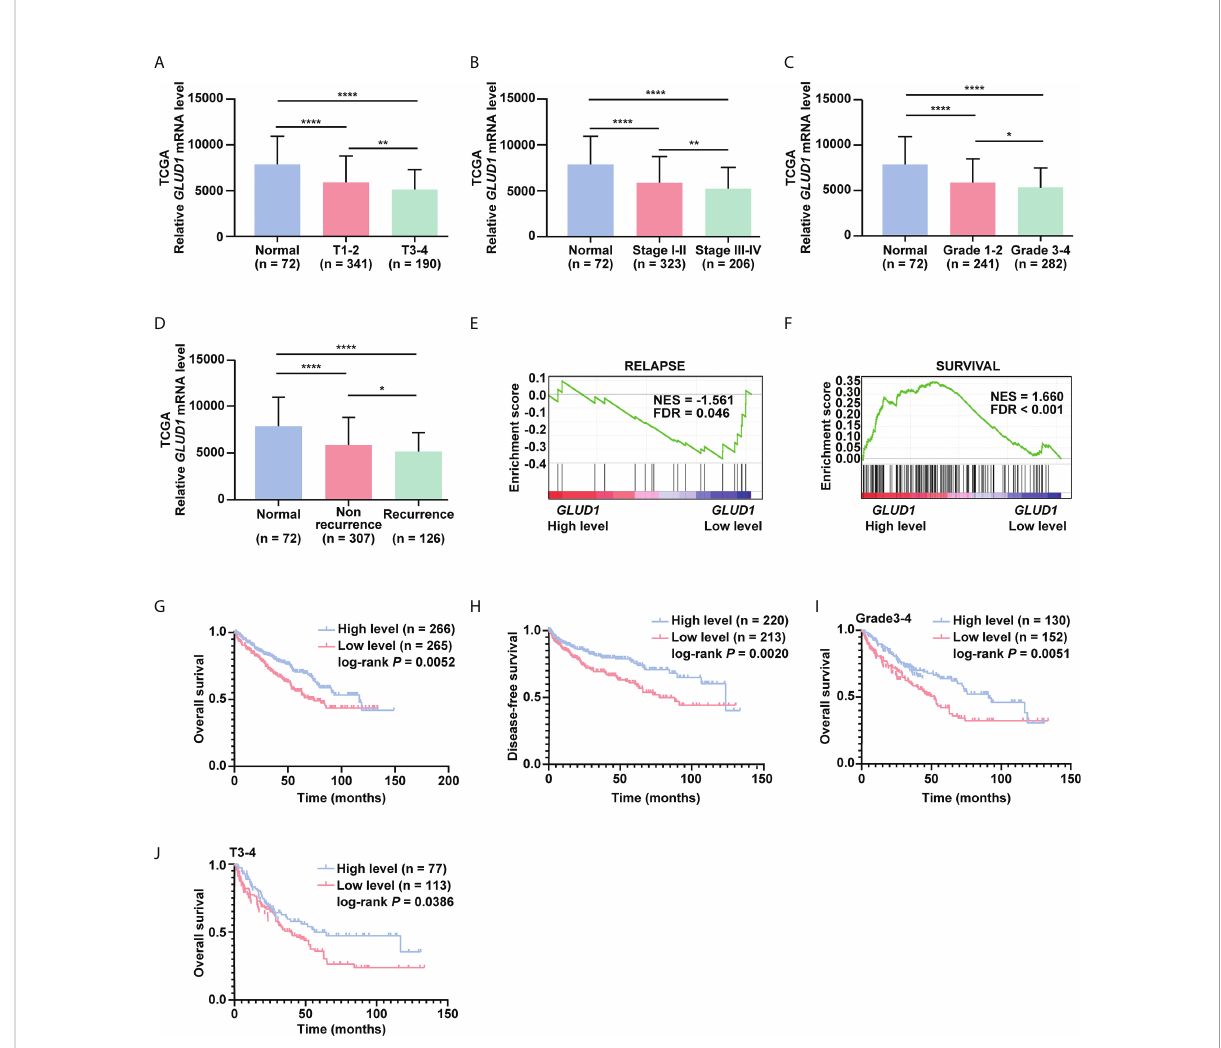
FIGURE 2 GLUD1 is a potential prognostic and TKI sensitivity predictive marker for ccRCC patients. (A – C) GLUD1 mRNA levels were gradually downregulated as T stage, AJCC stage and Fuhrman grade progressed. (D) GLUD1 mRNA level was negatively correlated with recurrence of ccRCC patients. (E, F) Enrichment plots of gene expression signature for relapse (SMID_BREAST_ CANCER_RELAPSE_IN_LUNG_UP) and survival (LEE_LIVER_CANCER_SURVIVAL_DN) were obtained by GSEA according to GLUD1 mRNA levels. The ccRCC samples from TCGA_KIRC database were divided into high and low GLUD1 expression groups according to the median value of GLUD1 RNA-seq quanti fi cation results. (G, H) The Kaplan-Meier (KM) curves of overall survival and disease-free survival based on TCGA_KIRC data. ccRCC patients were divided into high/low expression groups according to GLUD1 mRNA level. (I, J) KM curves of overall survival based on TCGA_KIRC data. Advanced ccRCC patients were divided into high/low expression groups according to GLUD1 mRNA level. * P < 0.05; ** P < 0.01; **** P <